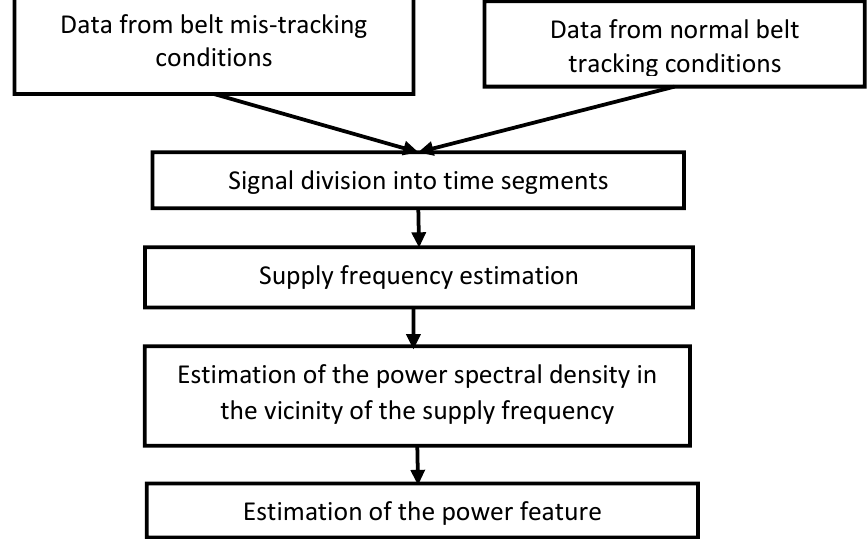
Figure 1. Power feature methodological flow chart.